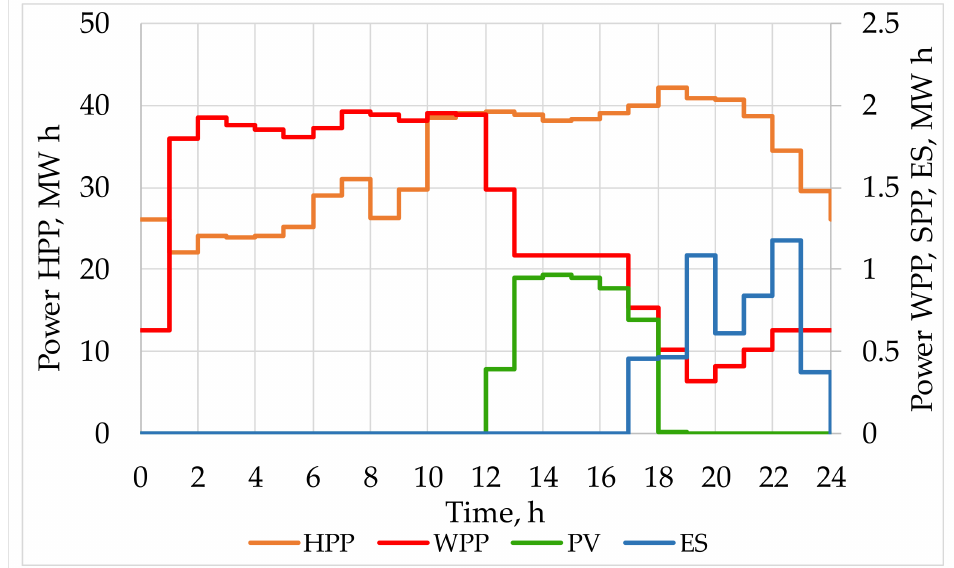
Figure 7. The optimal composition of alternative sources and energy storage to minimize the cost of power energy consumption.